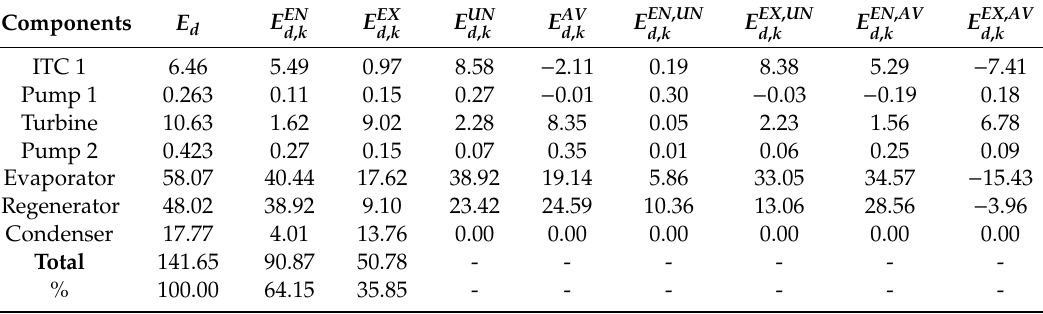
Table 11. Disaggregation of exergy for system